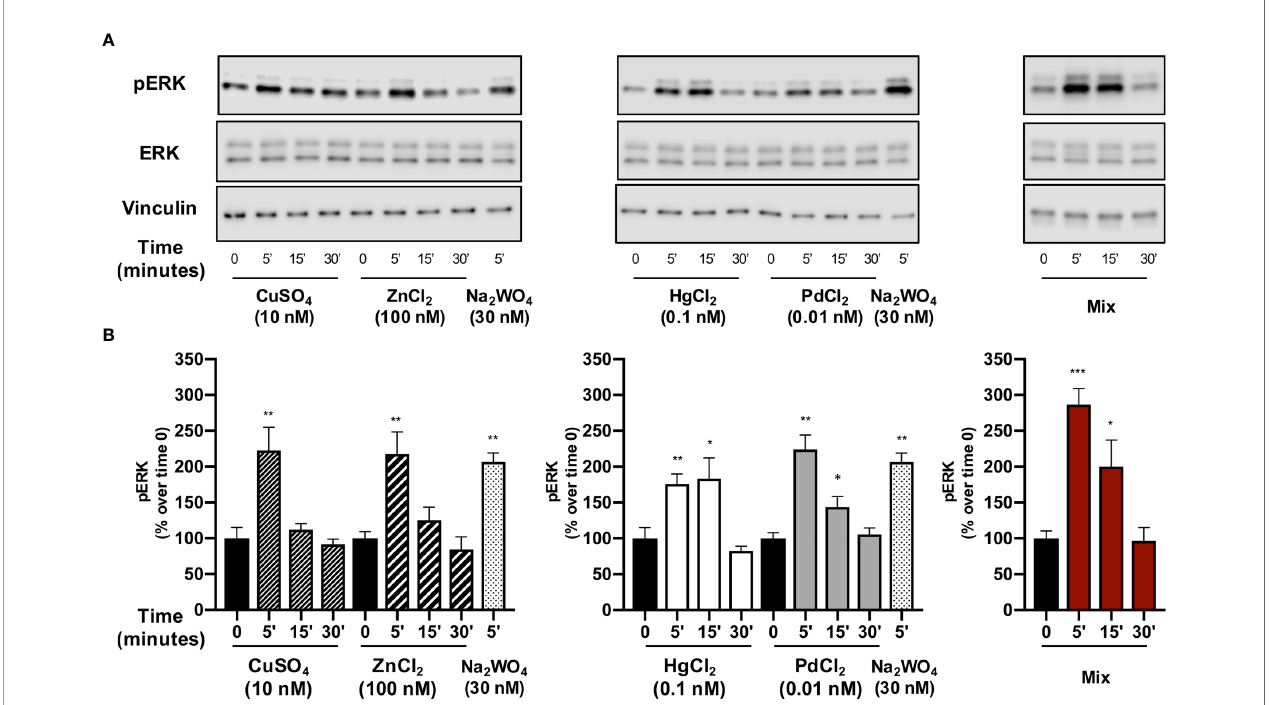
FIGURE 3 | The effect of metals on ERK1/2 phosphorylation in thyrospheres. Thyrospheres were treated for 30 min with the indicated metals at the concentrations causing maximum BrdU incorporation, lysed at the indicated times and analyzed for ERK1/2 phosphorylation by Western blot. (A) Representative immunoblots from six separate experiments. (B) Histograms represent the mean value ± SEM of densitometric values normalized to vinculin and expressed as percent of time 0. *p < 0.05, **p < 0.01, ***p <